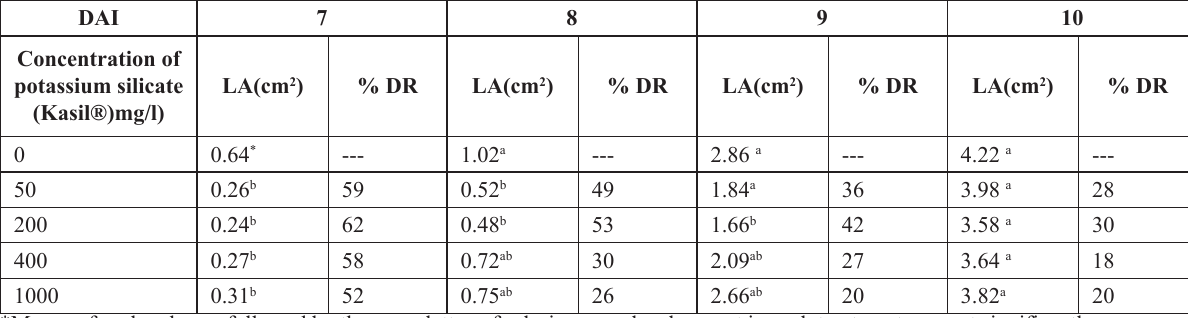
Table 2: Effect of postharvest treatment of potassium silicate (Kasil®) on the anthracnose development in chili pepper